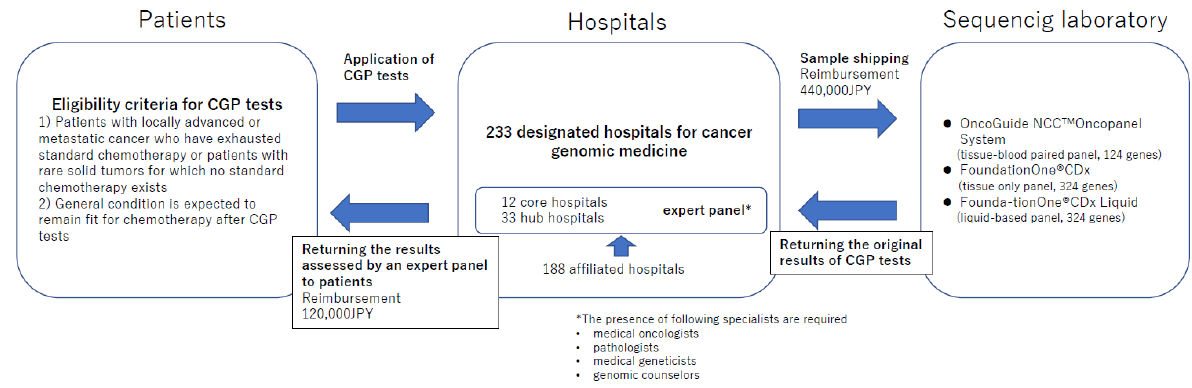
Figure 1. Standard flow of CGP tests in Japan.